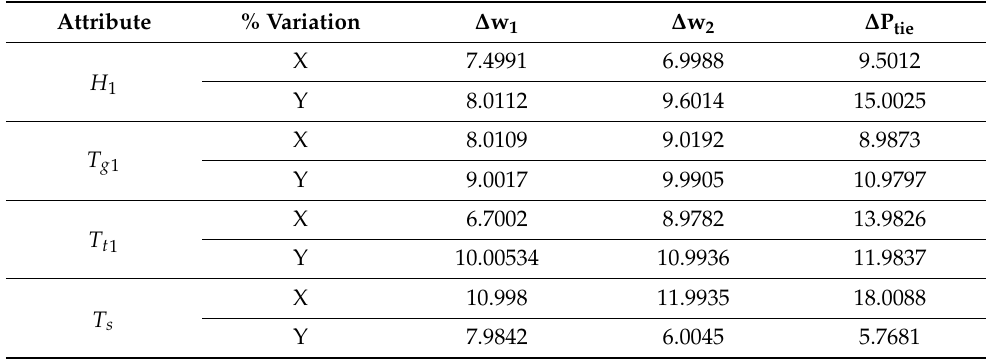
Figure 19. Overshoot variations through step load agitation. Table 9. Sensitivity investigation results (X = +25% and Y = −